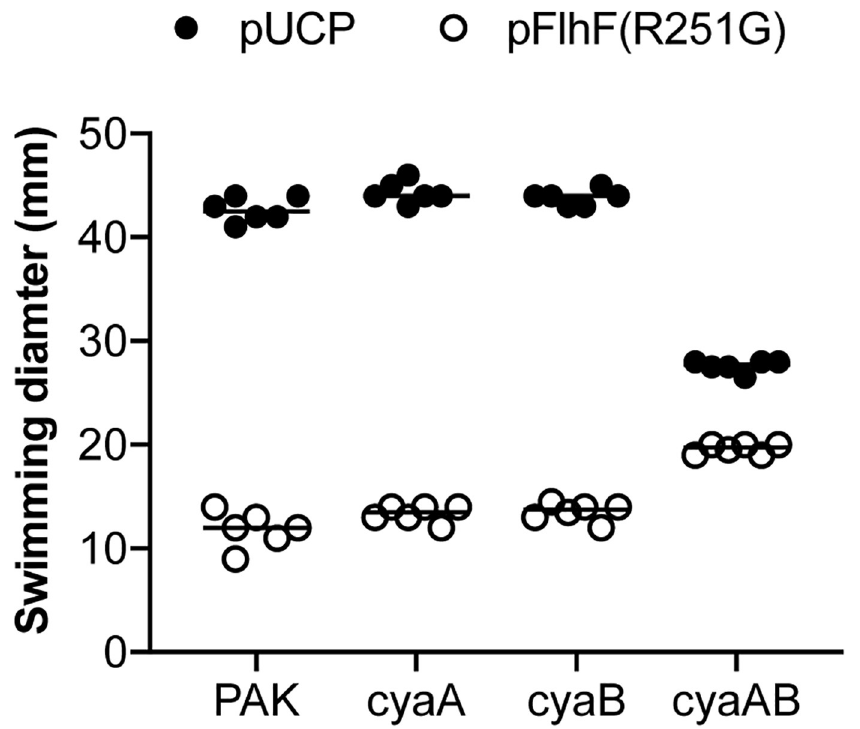
Fig 5. Deletion of both P . aeruginosa adenylate cyclases is required to suppress FlhF(R251G)-mediated inhibition of swimming. PAK or isogenic mutants lacking one or both of the P . aeruginosa adenylate cyclases were transformed with a plasmid driving constitutive expression of FlhF(R251G) or the empty vector, pUCP. Overnight cultures grown in VBM plus carbenicillin (200 μ g/mL) were adjusted to an OD 600 of ~0.3 and spotted to 0.3% LB agar plates supplemented with 250 μ g/mL carbenicillin. Bacteria were incubated at 30˚C for 20h before swimming zones were measured. The wild-type, cyaA , cyaB and cyaAB strains are